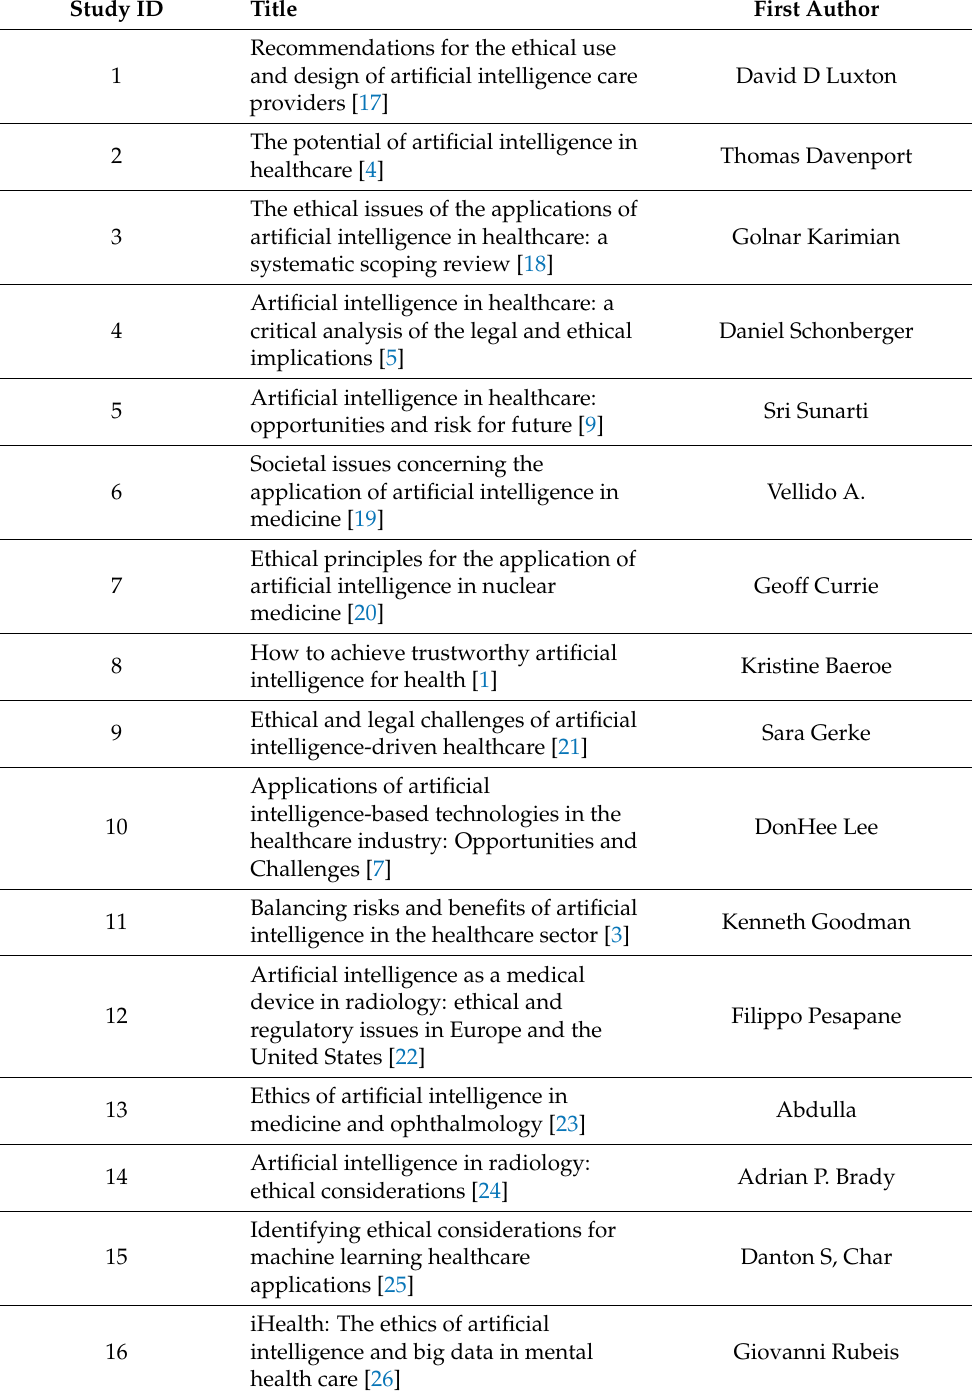
Table 1. Depicts the titles and first authors along with the study ID of the articles